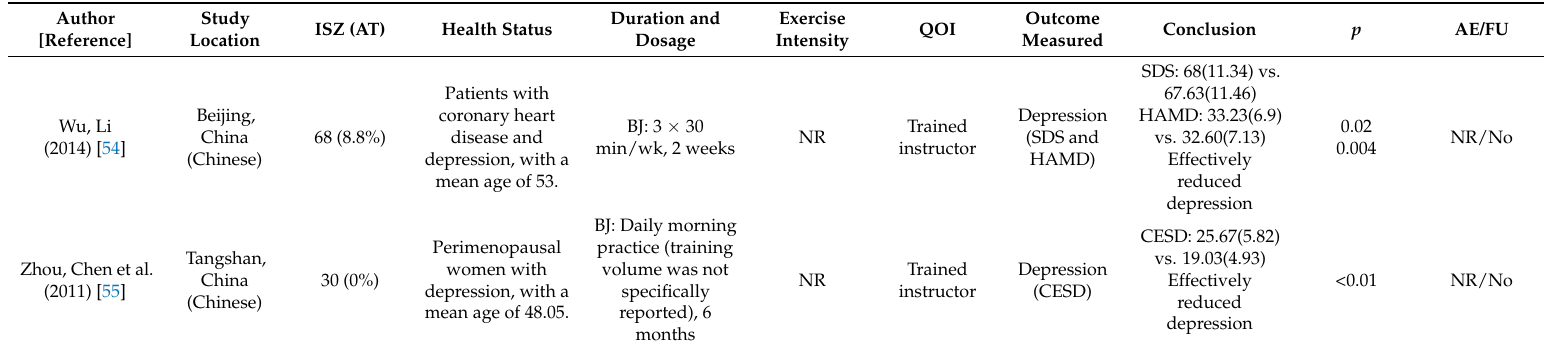
Table 2. Summary table for pretest and posttest